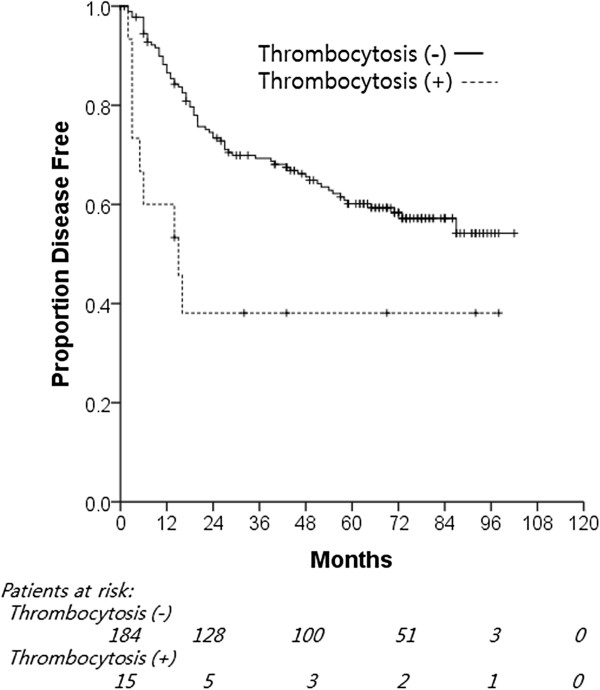
Correlation between preoperative thrombocytosis and disease-free survival. Kaplan–Meier plots of disease-free survival of patients with resectable NSCLC according to preoperative thrombocytosis (P = 0.005). NSCLC, non-small cell lung cancer.